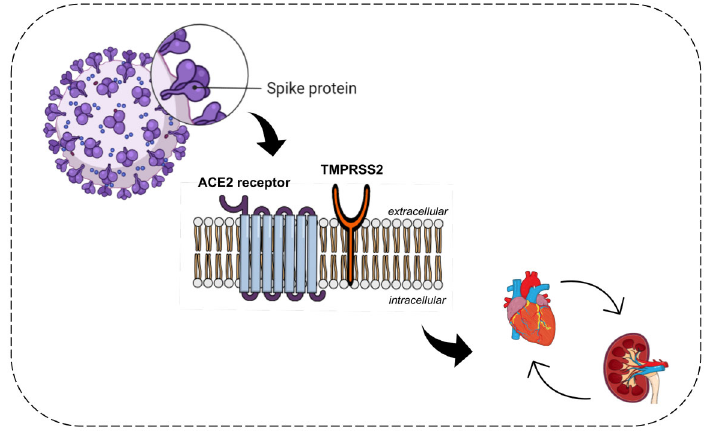
Figure 1. Schematic illustration representing the coronavirus entry into the cell and the consequences involving the cardiorenal syndrome. The spike protein (S) of SARS-CoV-2 allows entry of the virus into cells by binding to the angiotensin-2 converting enzyme (ACE2) and cell fusion provided by the serine protease TMPRSS2 for protein S. ACE2 is expressed in different organs, including the heart and kidneys, which have a close functional relationship in in fl ammation, electrical mechanisms, and/or activation of the sympathetic nervous system. This characterizes cardiorenal syndrome, in which cardiac and renal dysfunctions overlap. SARS-CoV-2 provides a link between coronavirus infection and cardiovascular and renal